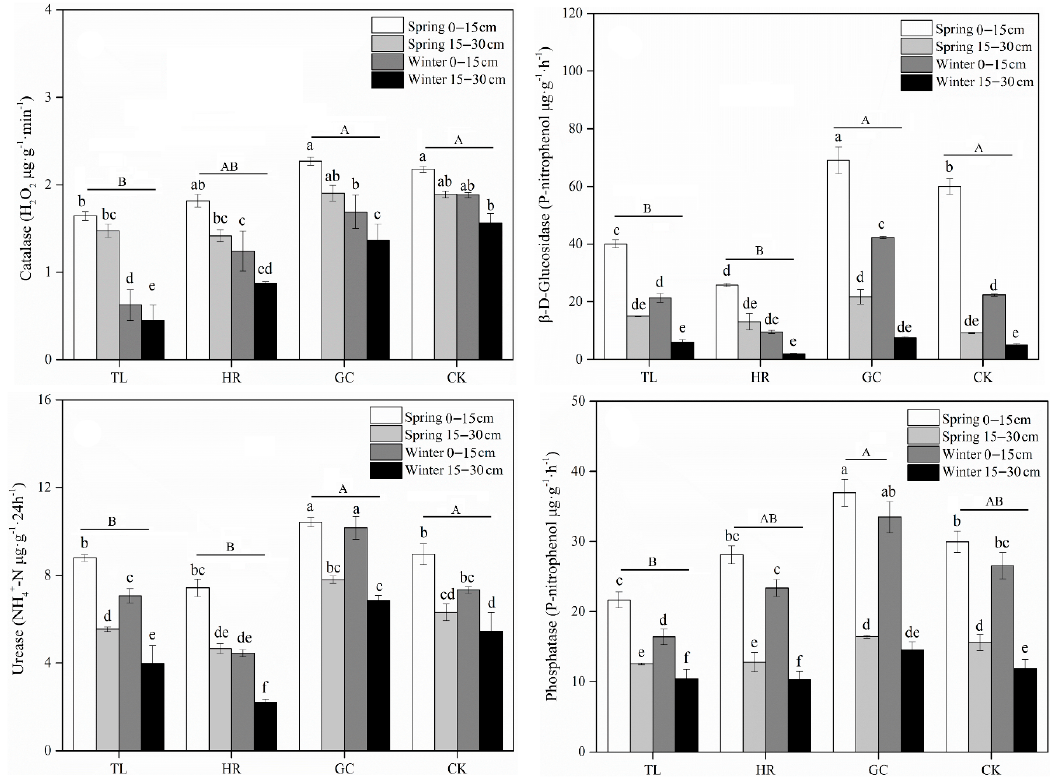
Figure 3. Di ff erences in soil enzyme catalase, β -D-glucosidase, urease, and alkaline phosphatase activity in the control and subsidence areas. Lowercase letters indicate significant di ff erences among samples based on Duncan’s multiple range test ( p < 0.05) while uppercase letters indicate di ff erences among sites.